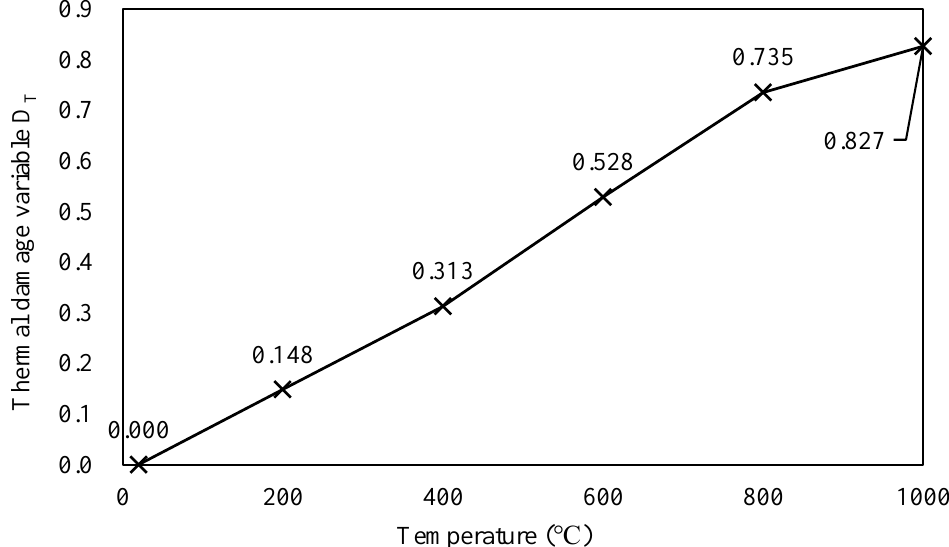
Figure 1. The average values of the damage variables of granite specimens exposed to different temperatures.